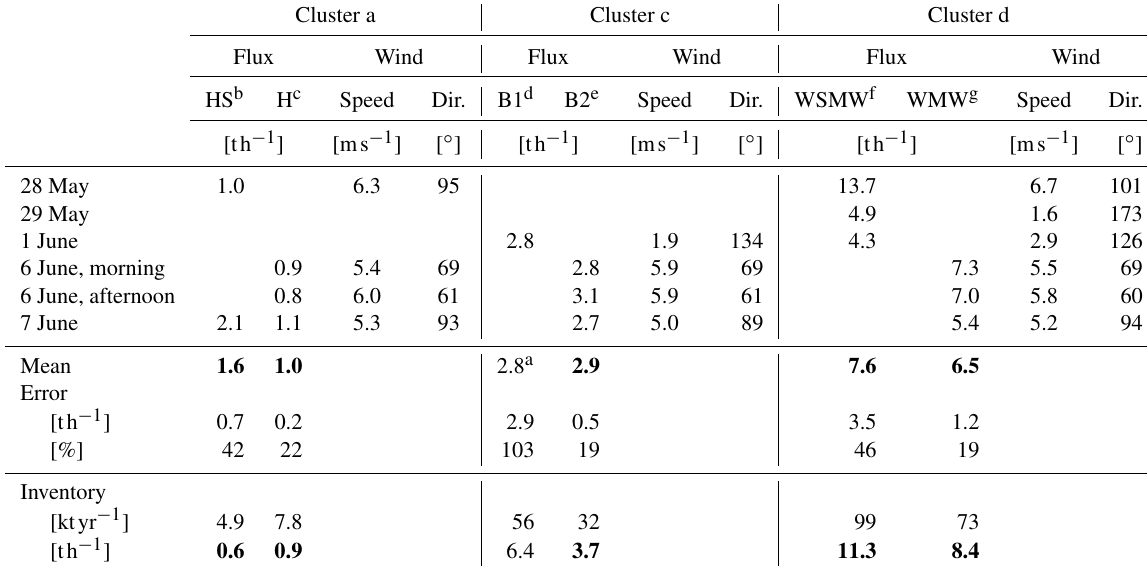
Table C1. Same as Table 2 but for clusters a, c, d, and without the errors of the single components. Cluster a Cluster c Cluster d Flux Wind Flux Wind Flux Wind HS b H c Speed